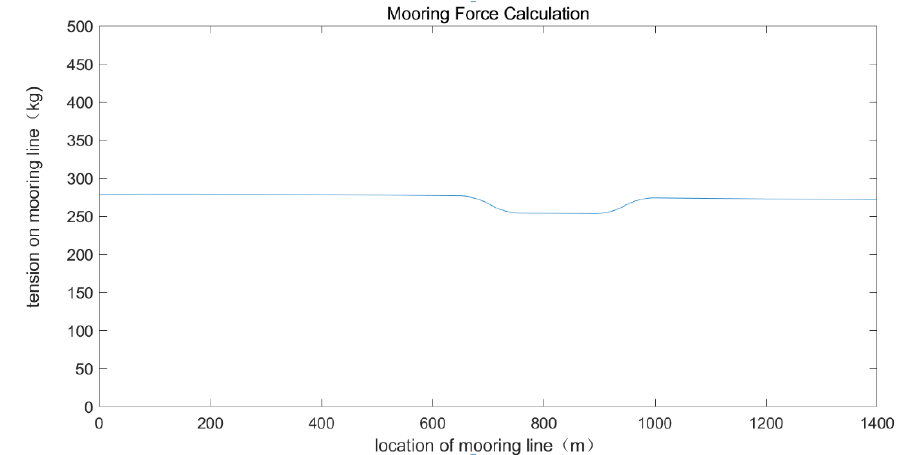
Figure 17. Mooring force property of the buoy under the wind speed of 10 m / s and current velocity of